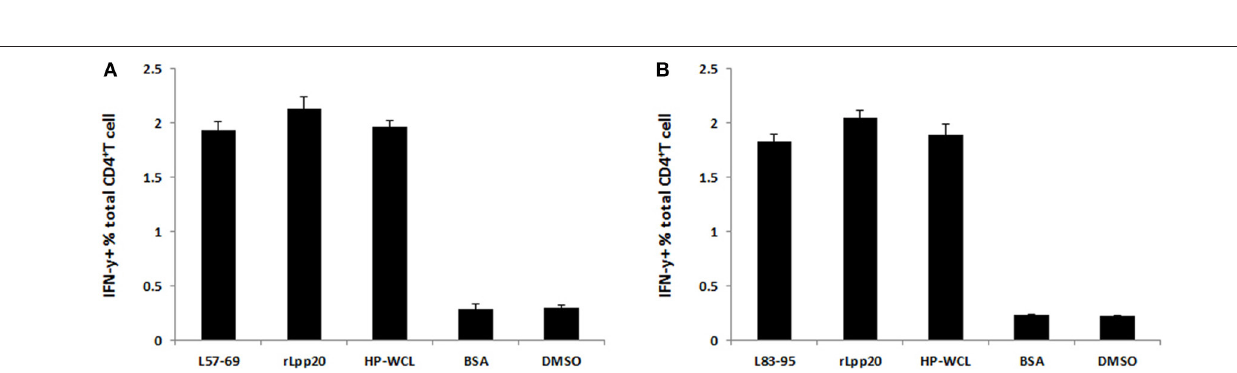
Frontiers in Microbiology | www.frontiersin.org